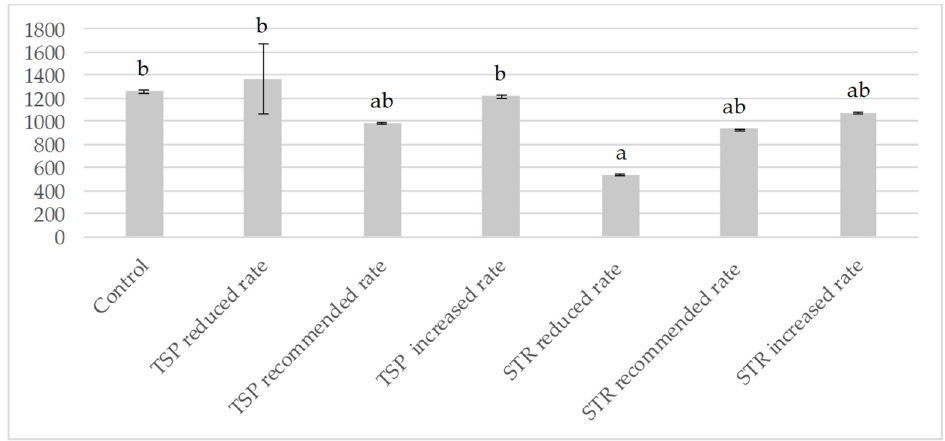
Figure 7. Salinity (mS cm − 1 ) as affected by the interaction of examined factors (A × B) at the level of significance α = 0.05 ( p value < 0.01).